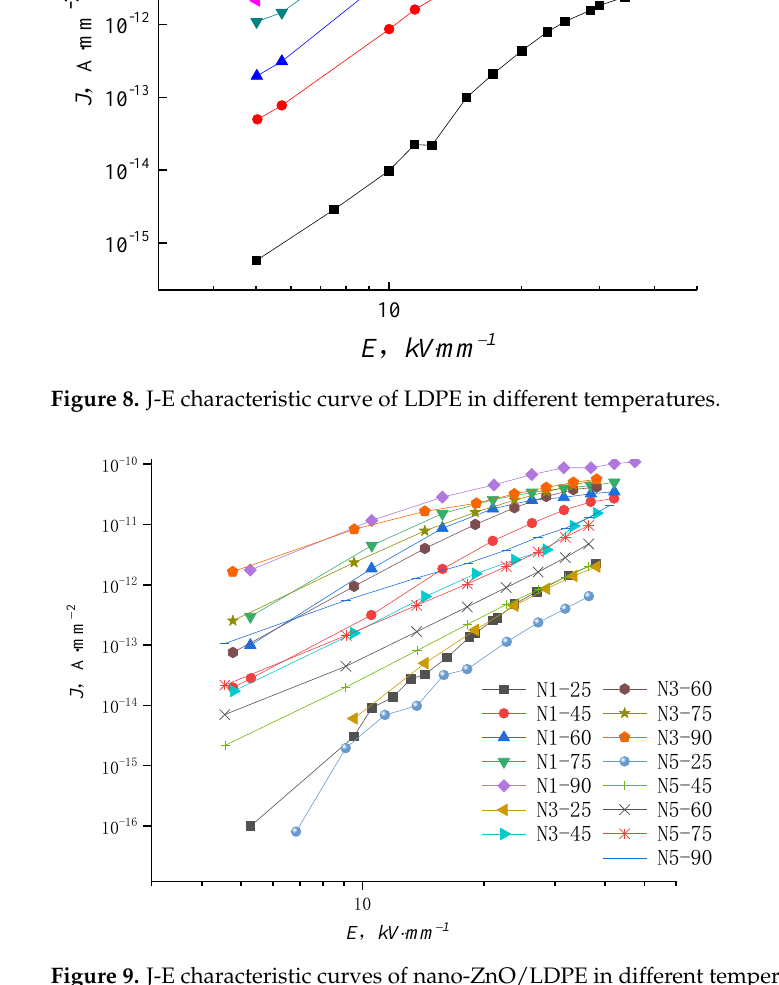
Figure 10. The J-E characteristic curves of M1, M3, M5 and M10 in different temperatures. The conductivity – temperature characteristic curve of samples P0, N5, and M5 under the 9 kV/mm field strength is shown in Figure 11. The conductance current increases with increasing temperature in all samples. The conductivity of the M5 samples rise quickly